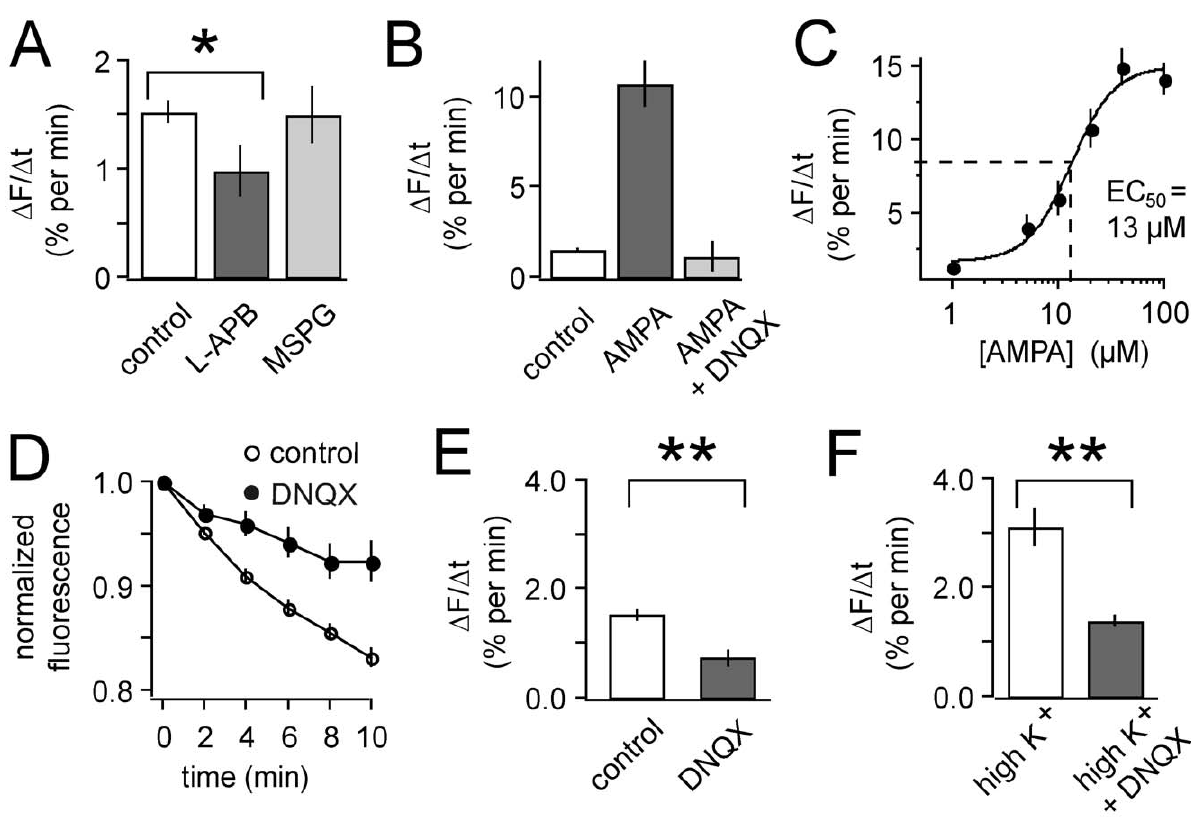
Figure 2. AMPA receptors mediate the acceleration of cone synaptic release. (A) Bath addition of 20 m M L-APB (an mGluR group III agonist) significantly slows release from cones in darkness ( p , 0.05, n =13). The mGluR antagonist MSPG (100 m M) has no effect on the dark release rate. (B) 20 m M AMPA markedly increases the release rate from cones ( n =16). The effect of AMPA is blocked by 10 m M DNQX ( n =10), leaving release insignificantly changed from the control rate in darkness. (C) Dose-response curve for release rate as a function of AMPA concentration. N =4–16 for each concentration. (D–E) Bath addition of 10 m M DNQX significantly slows release from cone terminals in darkness ( p , 0.001, n =21), suggesting that the physiological level of ambient glutamate boosts release. (F). High K + (50 mM) saline, which depolarizes cones, accelerated release from cone terminals to twice the dark release rate ( n =9). Addition of 10 m M DNQX greatly reduced the high K + evoked-release ( p , 0.01, n =7), suggesting that the glutamate released by cones elicits positive feedback. In this and subsequent figures, * denotes statistical significance of p , 0.05, while ** denotes p , 0.01.